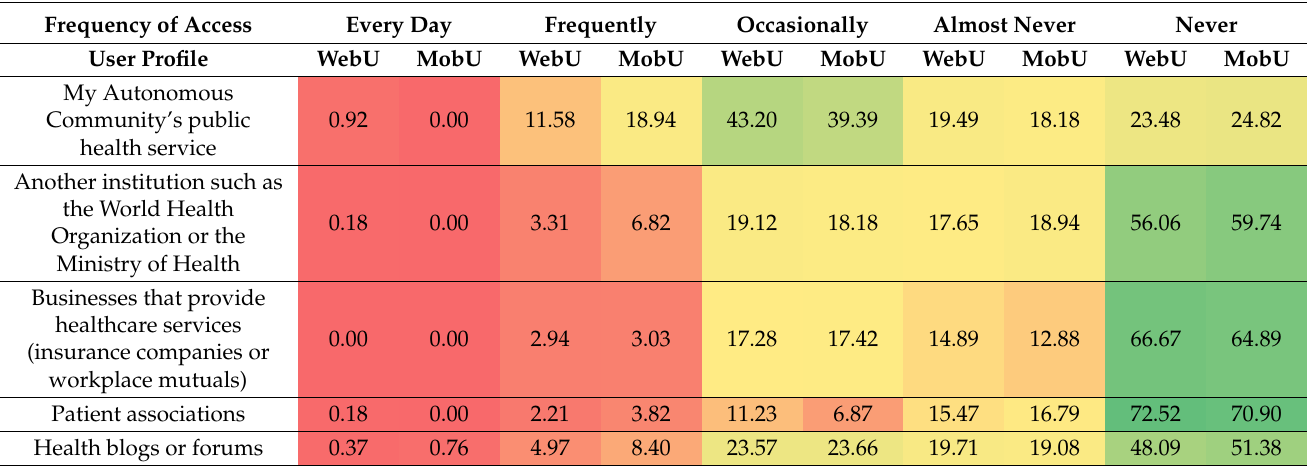
Table 1. Frequency of accessing health information sources (by user profile).